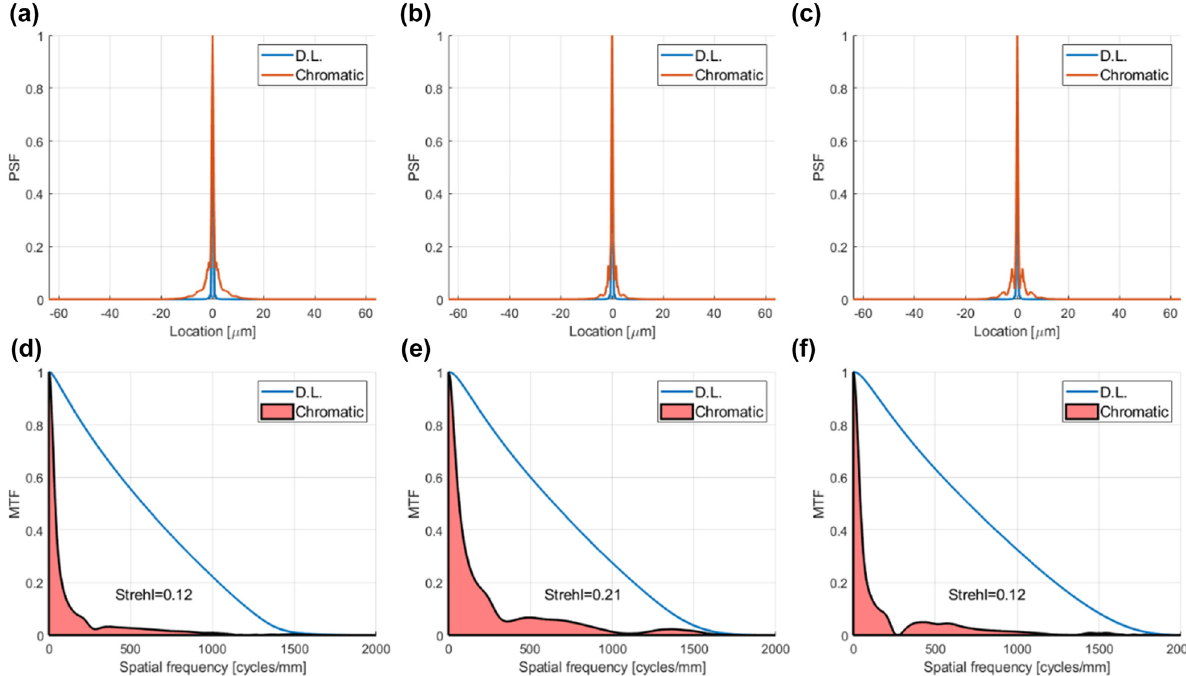
Figure 9: PSFs and MTFs of conventional diffractive lens (with parameters equivalent to EDOF lens) over RGB spectral ranges, defined